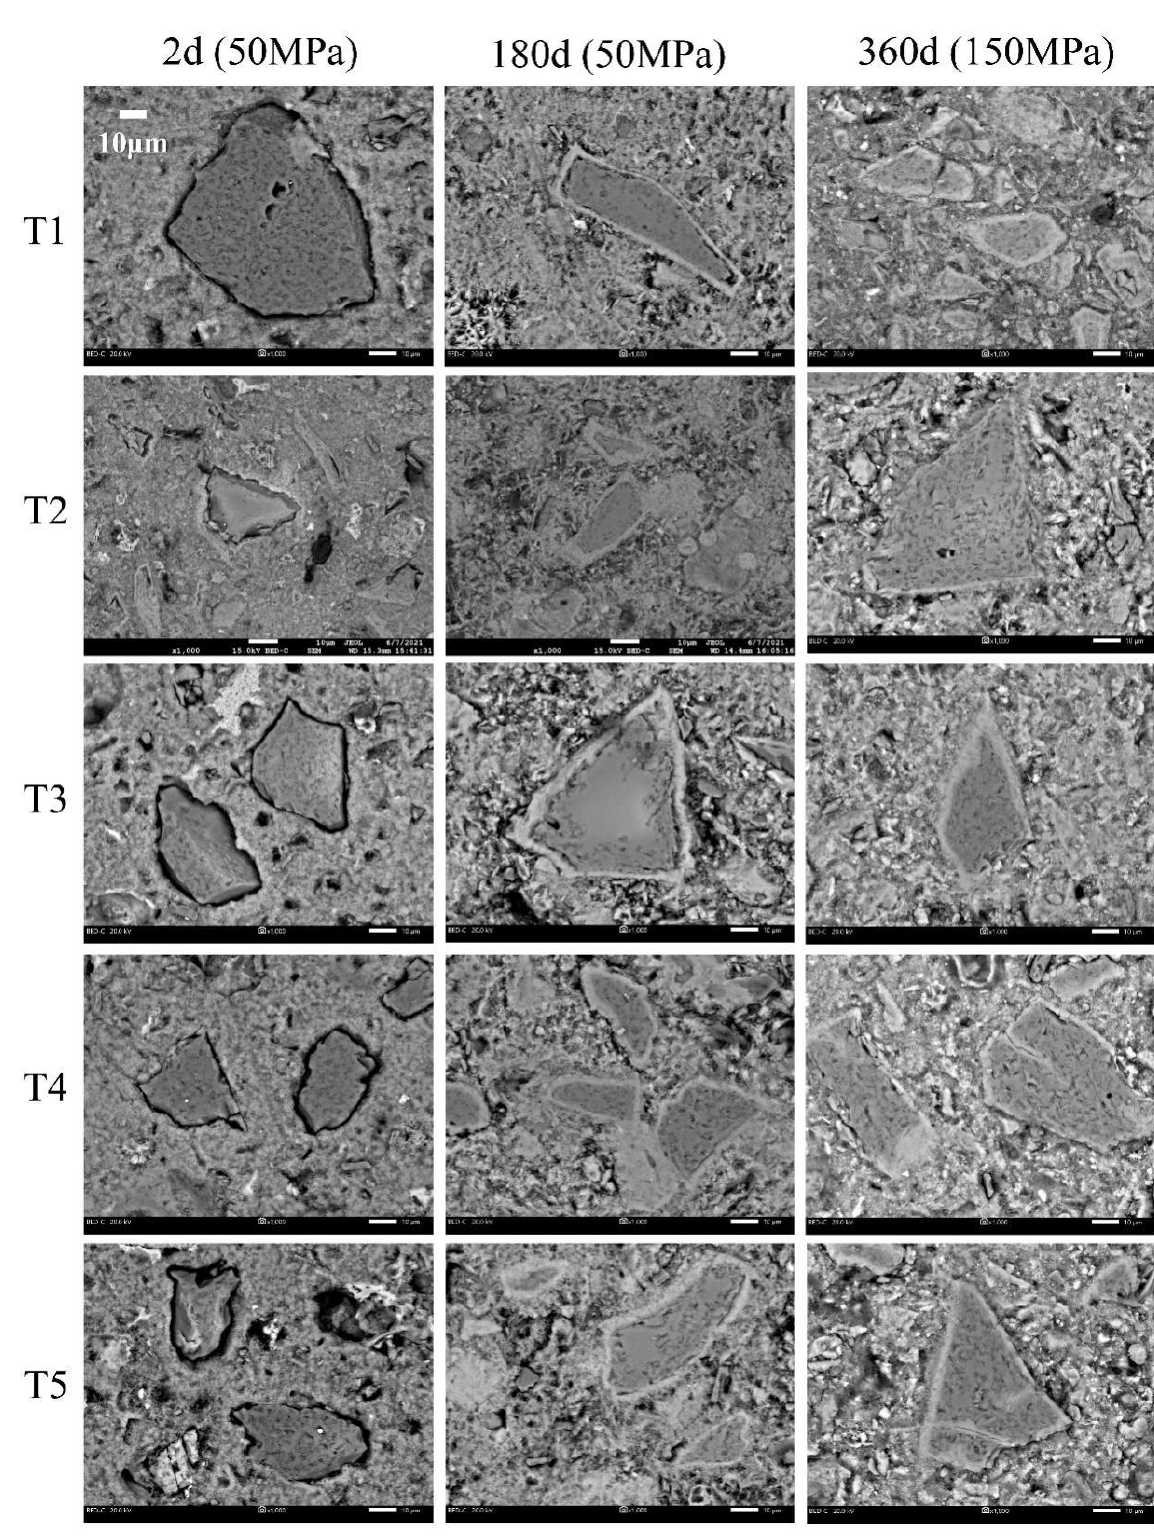
Figure A1. SEM-BSE analysis of slurries T1 to T5 (×1000).